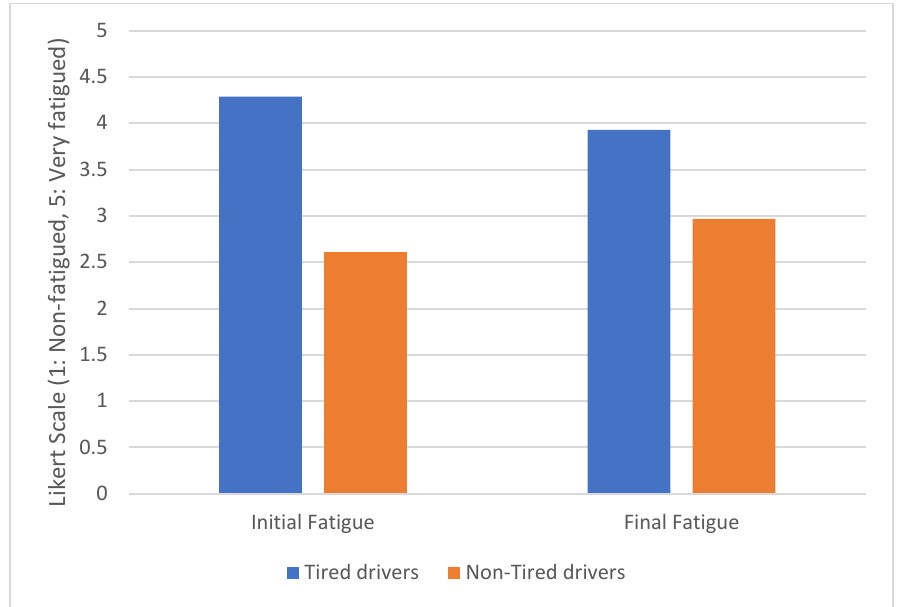
Figure 7. Fatigue evolution.